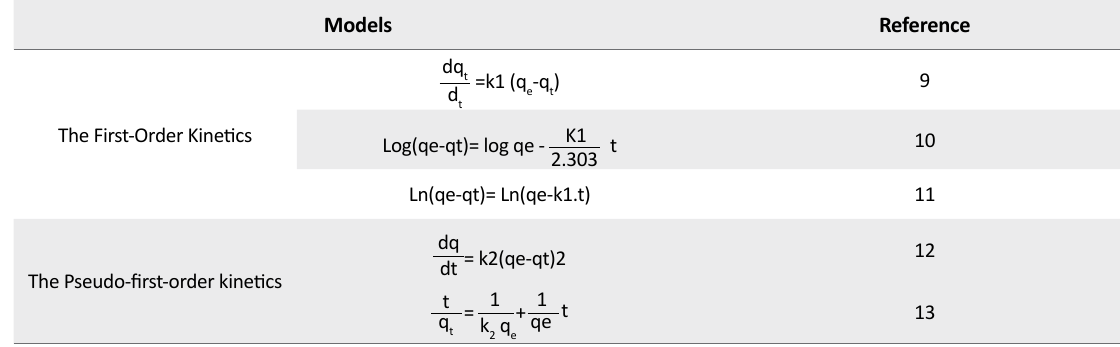
Table 3. Model of the kinetics of adsorption of nitrite, phosphate, and